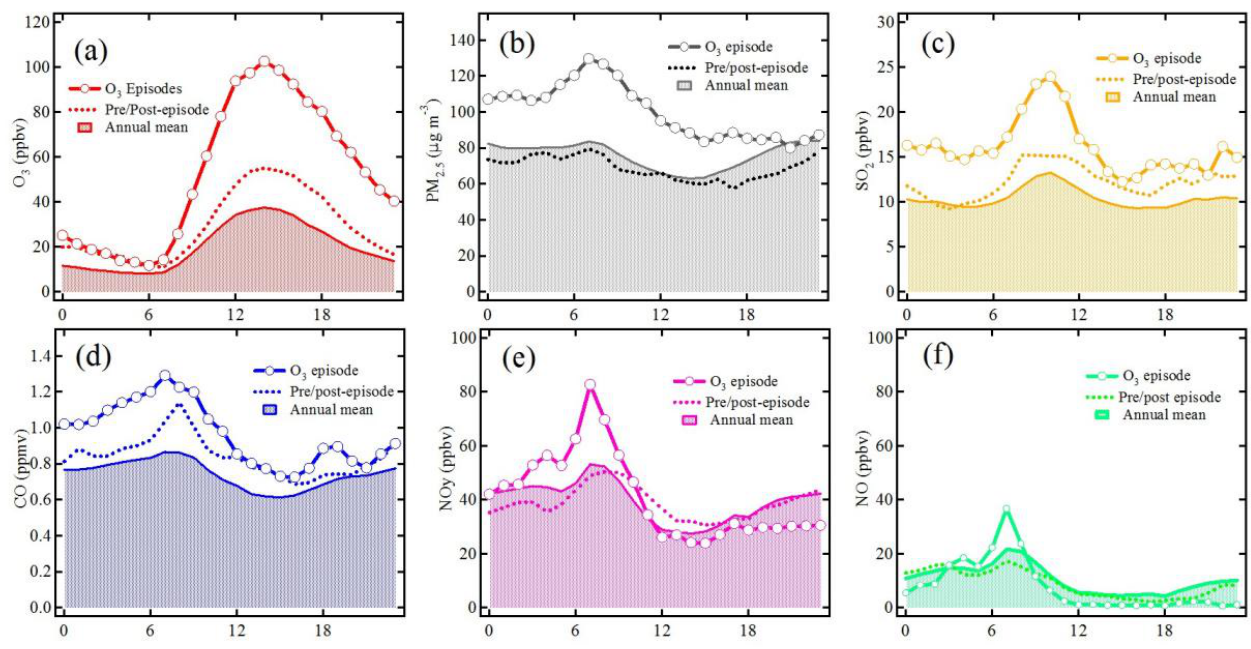
1 Fig. 5. Diurnal variations of (a) O 3 , (b) PM 2 . 5 , (c) SO 2 , (d) CO, (e) NO y , and (f) NO, averaged for O 3 episode days with exceedances of the NAAQS-CN and the pre-/post-episode days during the entire 1y period. Figure 5. Diurnal variations of ( a ) O averaged for O days during the entire 1-year period. 4